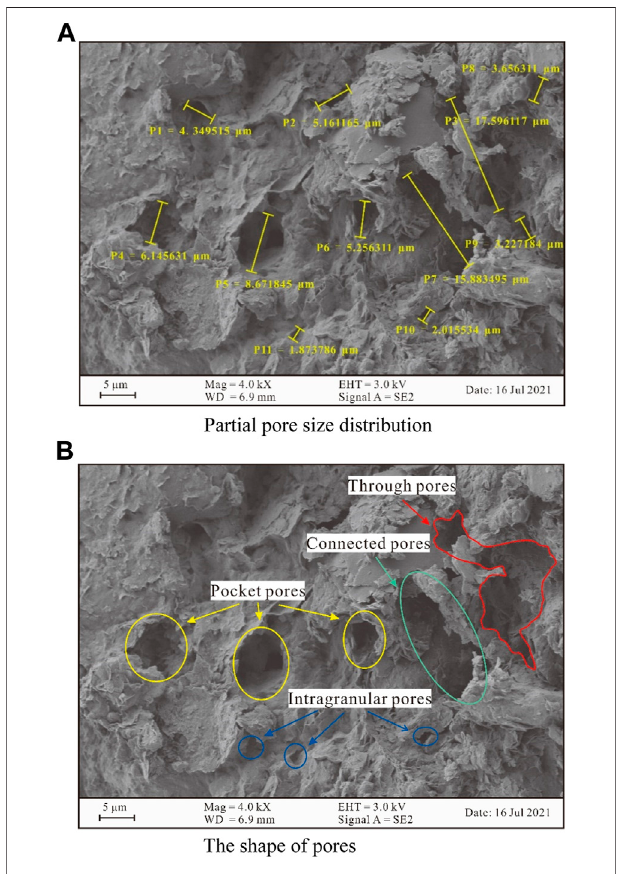
FIGURE 11 | Pore size and shape characteristics: (A) partial pore size distribution; (B) the shape of pores.